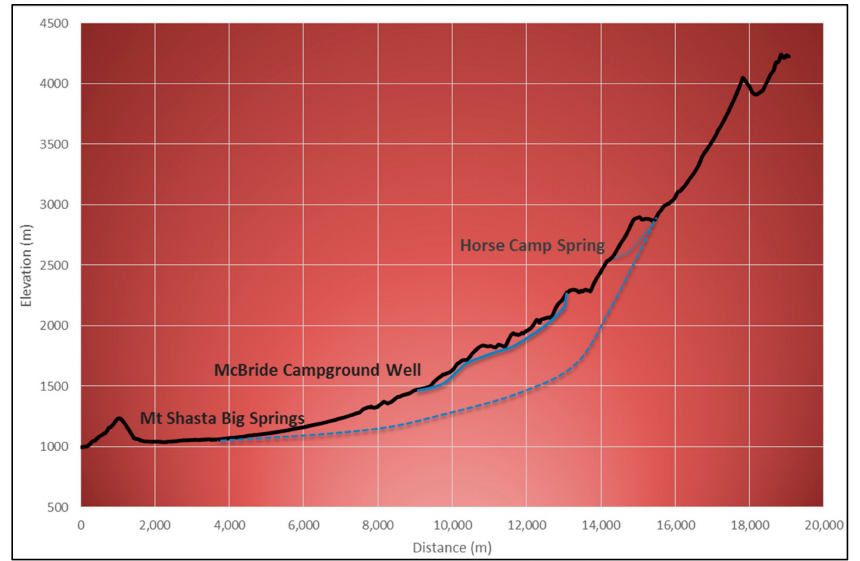
Figure 8. Topographic cross section of Mt. Shasta within the study area, along with three schematics, example flow paths from recharge areas (as predicted by δ 18 O results) to sampling locations (dotted line represents a schematic flow path to Horse Camp Spring; solid line to McBride Campground Well; dashed line to Mt Shasta Big Springs). The maximum depth of each flow path is based on the difference between recharge temperatures (predicted by noble gas analyses) and observed discharge temperatures, corrected for gravitational heating. (Vertical exaggeration